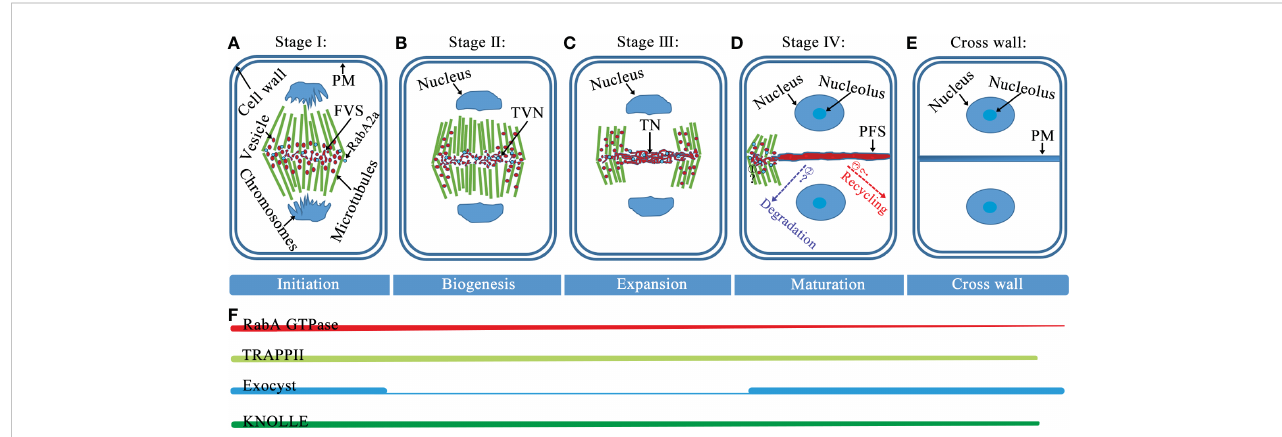
FIGURE 1 Model of cell plate formation stages and spatiotemporal distribution of Rab GTPases, tethers, and SNAREs. (A) Stage I, at this fusion of vesicles stage (FVS), during the initial fusion and fi ssion of the bladder, the dumbbell structure forms. (B) Stage II, vesicles undergo fusion, fi ssion, and conformational changes to form a tubulo-vesicular network (TVN). (C) Stage III, the TVN gradually merges into a tubular network (TN). (D) Stage IV, as the cell plate continues to smoothen and expand, the formation of a planar fenestrated sheet (PFS). The cell plate extends fusion tube connecting to the cell plate fusion site with PM and fuses with PM (Step1), and the black question mark indicates an unknown mechanism. After the cell plate is anchored to PM, the proteins diffused from the cell plate would be recycled and/or degraded (Step2 and 3), and dashed arrows with question marks indicate where these proteins are likely to go. (E) At the end of cytokinesis, the cell plate enters maturation when the new primary cross wall and daughter cells separate. (F) The association of RabA GTPase with the membrane provides cargo for cell plate formation and remains present throughout cell plate formation. Both TRAPPII and exocyst complexes are present at the onset of cytokinesis. Thereafter, the TRAPPII complex consistently marks the cell plate from cytoplasmic division and it is required for its biogenesis, while the outer capsule is primarily required for the maturation of the cell plate. Throughout the cell plate formation phase, SNARE-dependent membrane vesicles fuse to form the cell plate. Abbreviations: PM, plasma membrane; FVS, fusion of vesicles stage; TVN, tubulo-vesicular network; TN, tubular network; and PFS, planar fenestrated